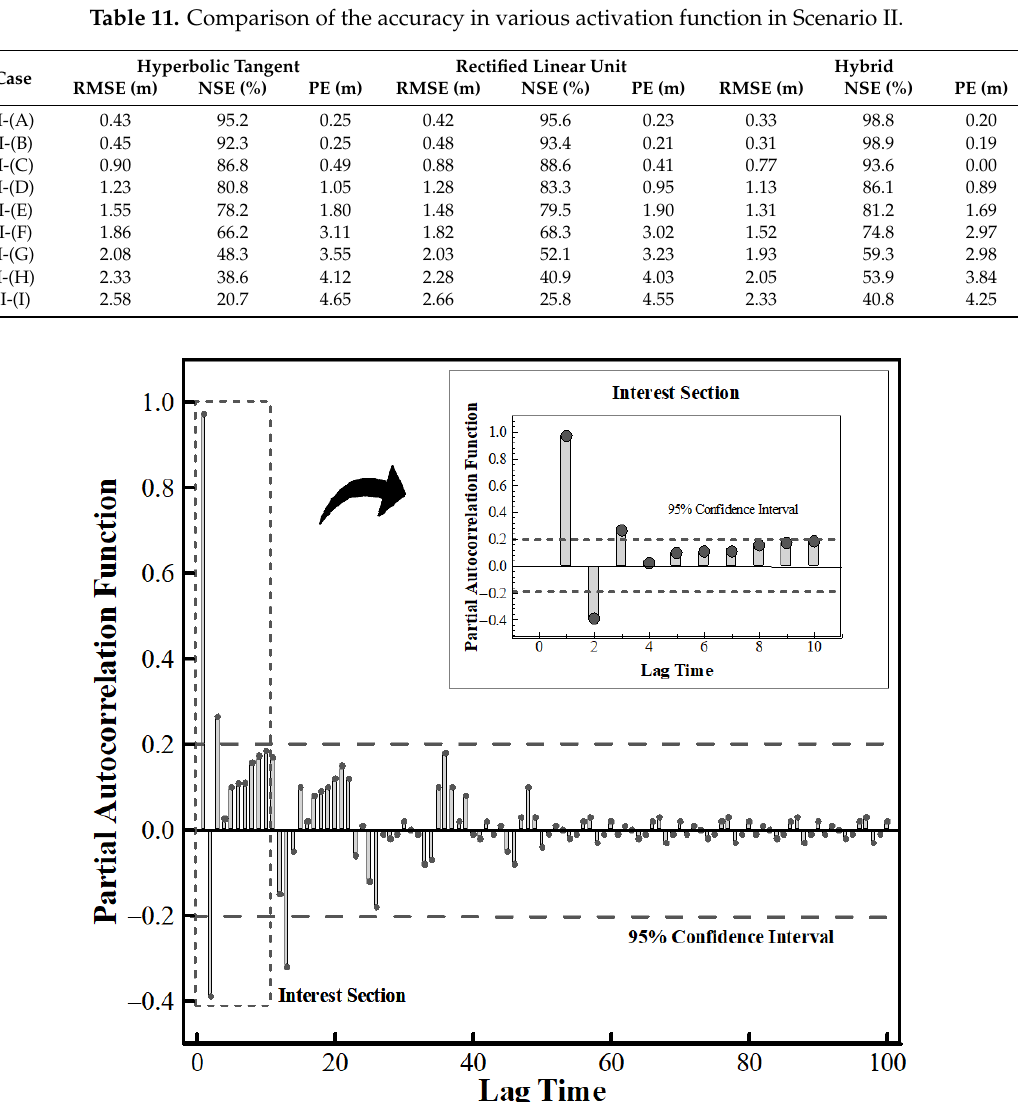
Figure 8. Partial autocorrelation of water surface elevation at Hangang River.